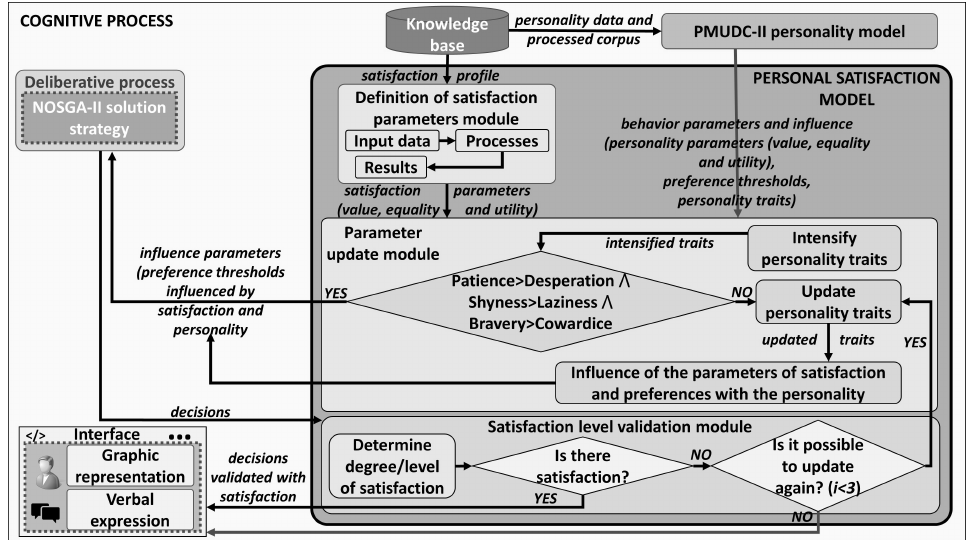
Figure 2. Proposed satisfaction model and the interaction of its process